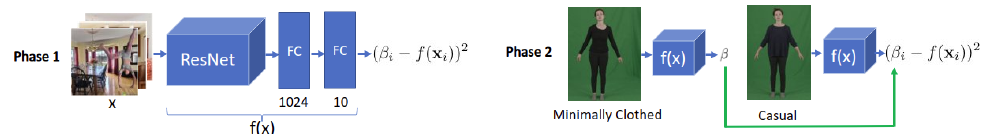
Figure 2. Phase 1 : the proposed model takes as input an image of a person and regresses the SMPL shape parameters β . Phase 2 : the trained model is used to extract β parameters from the minimally clothed images. The parameters are assigned to each image of the same individual and the network if